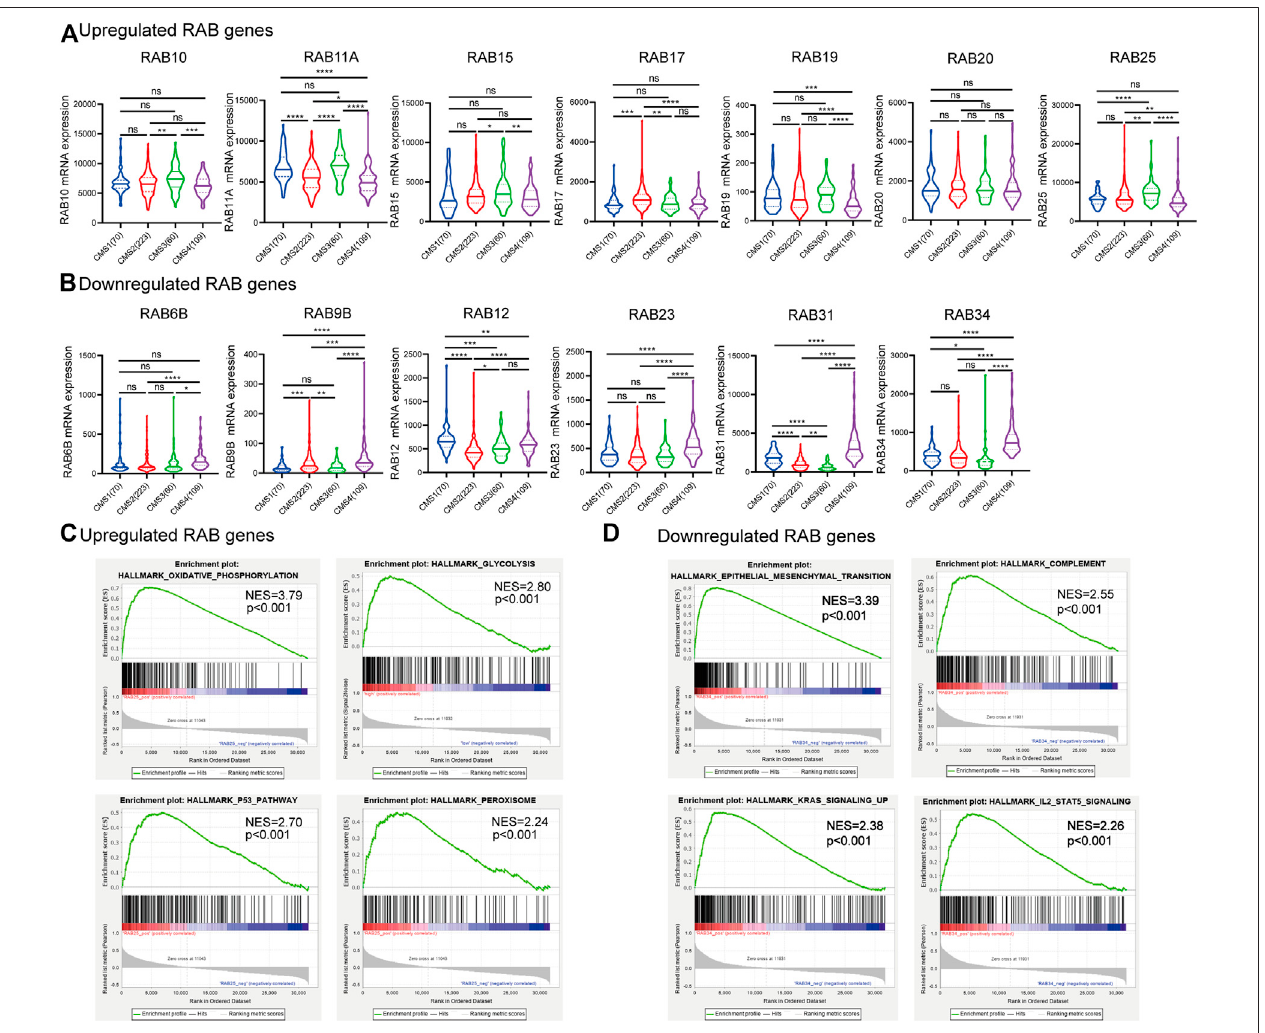
FIGURE 2 | Correlation between RABs expression and CMSs and GESA enrichment analysis in CRC patients. (A) 7 RABs (RAB10, RAB11A, RAB15, RAB17, RAB19, RAB20, and RAB25) were signi fi cantly correlated with CMS3. (B) 6 RABs (RAB6B, RAB9B, RAB12, RAB23, RAB31, and RAB34) were signi fi cantly correlated with CMS4. Statistical signi fi cance was de fi ned by a two-tailed t -test. (C – D) Gene set enrichment analysis of RABs. * p < .05, ** p < .01, *** p < .001, **** p < .0001.